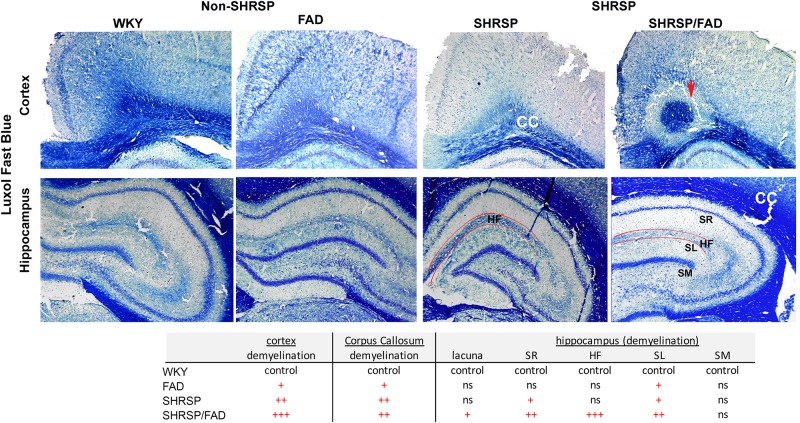
Demyelination in the cortex, corpus callosum and the hippocampal fissure of SHRSP/FAD rats. Sections were stained with Luxol fast blue to visualize changes in myelin distribution between the different strains. Qualitative evaluation by a blinded experimenter showed changes in myelin in both regions among the strains. Top panels show extensive, evenly spread Luxol fast blue staining, which densely labeled the corpus callosum (CC) of WKY rats. However, in FAD rats, there were dark patches of Luxol fast blue, interspersed with white patches of demyelination. In contrast to these minor changes in FAD rats, there was a notable loss of myelin patches in the CC and cortex of SHRSP and SHRSP/FAD groups. The top right panel shows a lacuna in the cortex-CC interface surrounded by a halo of demyelination (red arrow). There was no change in Luxol fast blue in the stratum molecular (SM) among strains, but in the FAD and SHRSP rats, there was some loss of myelin in the stratum radiatum (SR) and lucidum (SL) reflected by irregular patches of blue in the FAD rat, with more extensive loss in the SHRSP/FAD rats. The most pronounced loss of myelin was seen in the hippocampal fissure of SHRSP/FAD rats.